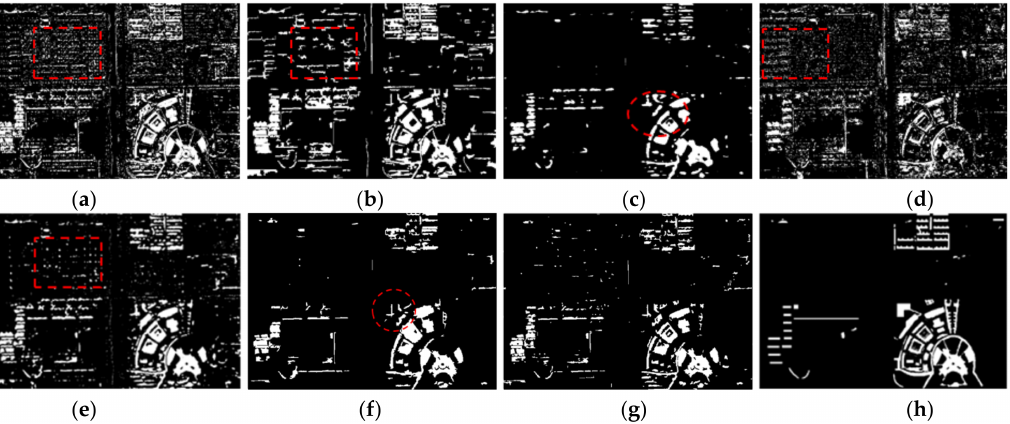
Figure 11. Binary change maps of Mingfeng data set generated by different methods: ( a ) CVA;